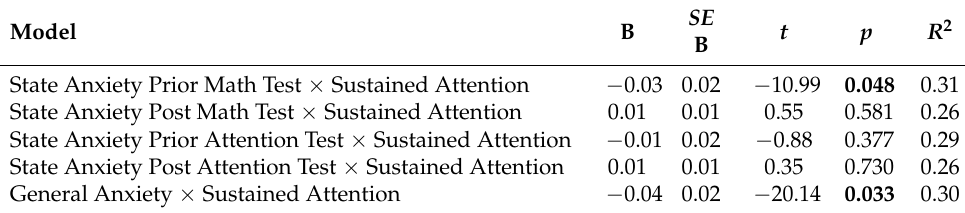
Table 3. Moderated regression analysis of math achievement with the predictor anxiety and the moderating variable sustained